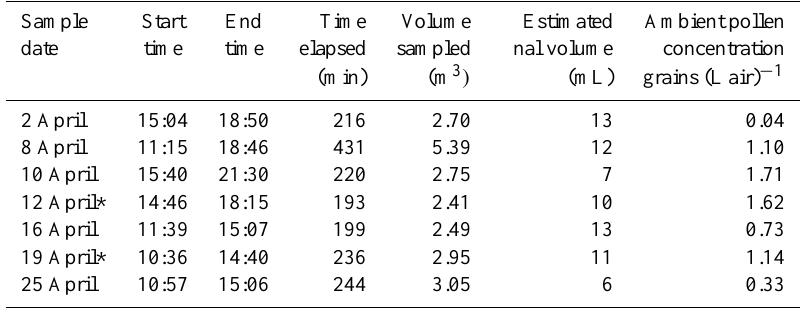
Table 1. Summary of swirling aerosol collector sampling times.